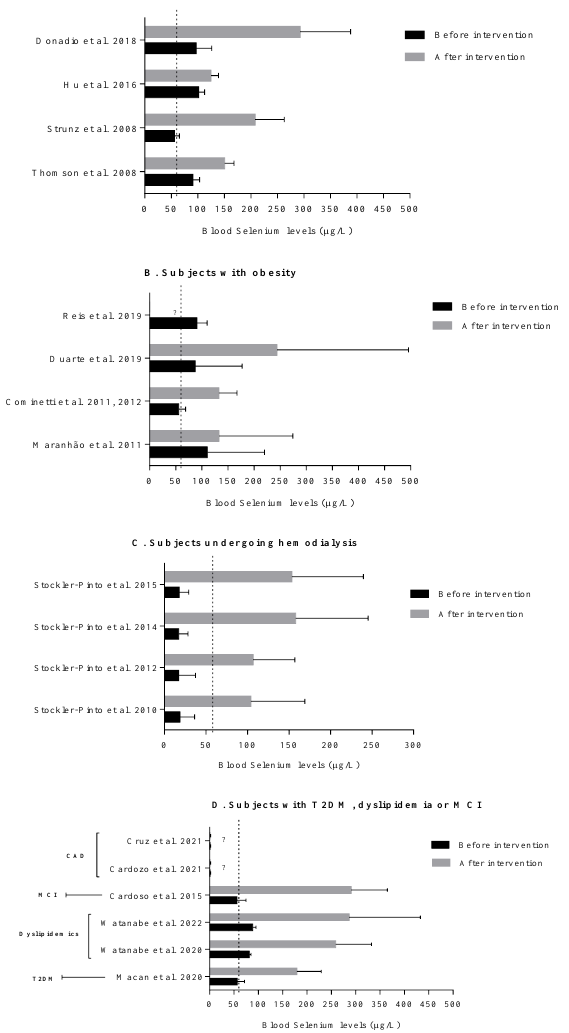
Figure 4. Blood selenium levels (plasma or serum or total blood) before and after Brazil nut supplementation in ( A ). healthy subjects [14,18,24,34], ( B ). subjects with obesity [15,19,20,26,27], ( C ). subjects undergoing hemodialysis [25,28–31], and ( D ). subjects with type 2 diabetes mellitus (T2DM) or using statins or mild cognitive impairment (MCI) or with coronary artery disease (CAD), ?, not informed